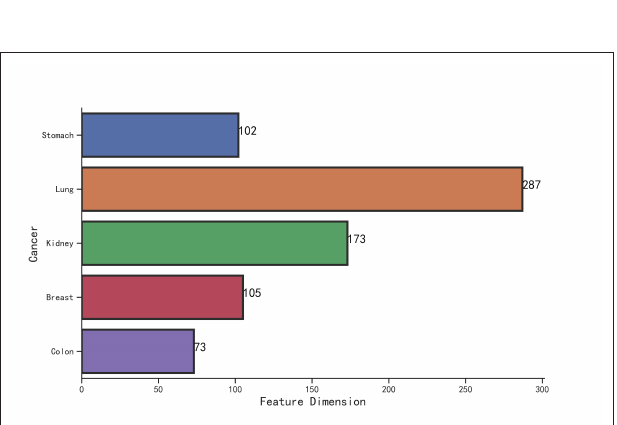
FIGURE 3 | The number of genes selected by